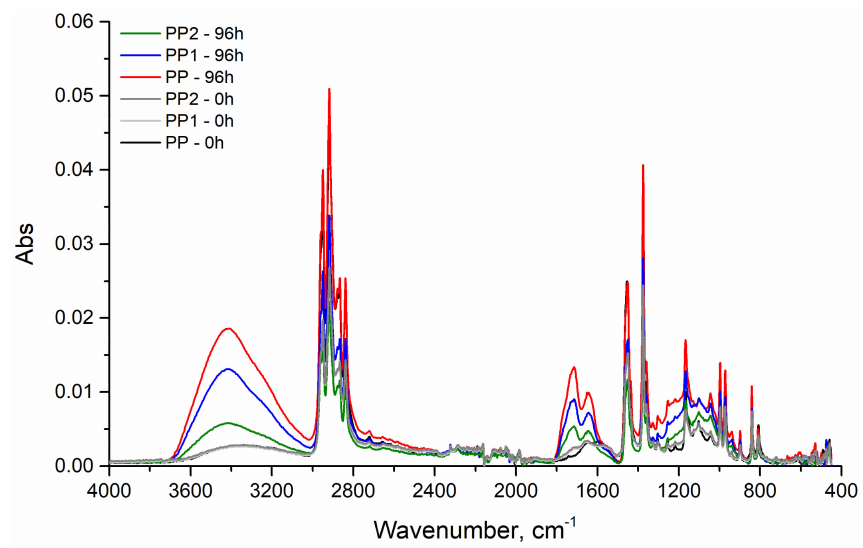
Figure 12. ATR spectra of the polypropylene and polypropylene nanocomposites after 96 h of exposure.